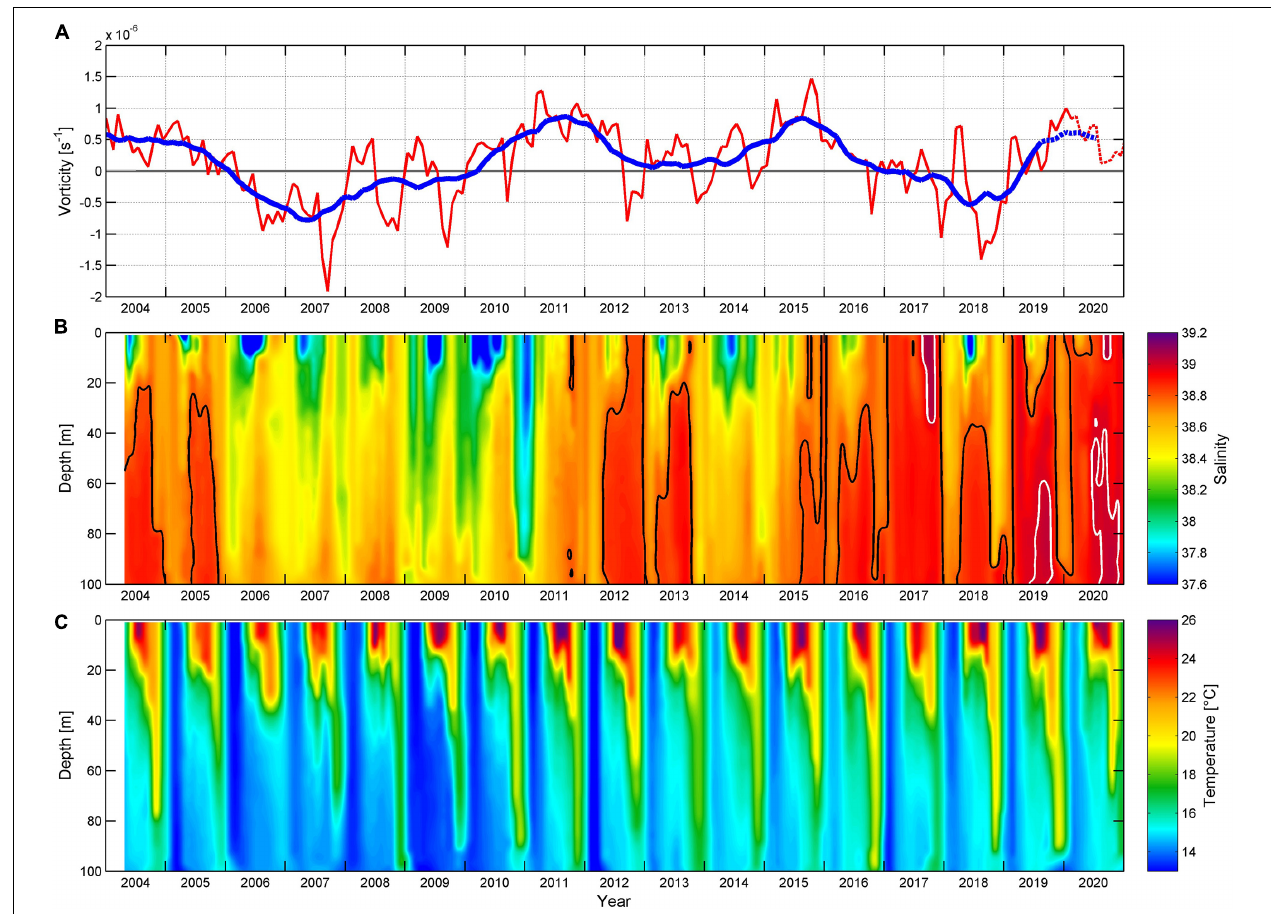
FIGURE 6 | (A) Monthly time series of the spatially averaged current vorticity (red line) and low-pass filtered (13 months) current vorticity (thick blue line) computed in the Northern Ionian Sea (37–39 ◦ N; 17–19.5 ◦ E) between January 2004 and December 2020. Dashed parts in panel (A) denote vorticity data based on near real time AVISO + product. (B) Hovmöller diagram of salinity measurements at station CJ009 between April 2004 and December 2020. Thick black line in panel (B) indicates 38.8 salinity contour (high salinity conditions), while thick white line denotes 39.0 contour (exceptionally high salinities). (C) Hovmöller diagram of temperature measurements at station CJ009 between April 2004 and December